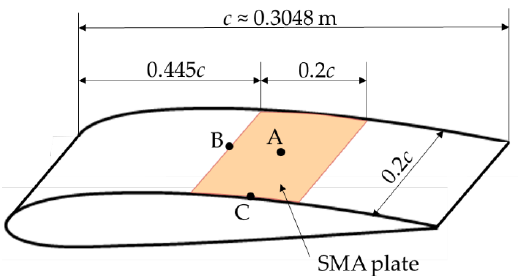
Figure 10. Conceptual sketch of a shape memory alloy (SMA) plate that is fixed on all four sides on an airfoil suction side with a chord length ( c ) of 1 ft (≈0.3048 m) based on [77]. In the initial stage the SMA plate has the shape of the original airfoil and is pre- strained, which means that the initial strains in chordwise and spanwise directions are negative. The initial temperature of the plate is −5 °C at which the SMA is fully martensitic. When the temperature is increased the SMA transforms into the austenitic phase. At the three considered points on the plate this transformation starts at about −1.8 °C and is fully completed for the point A in the middle of the plate at 6.2 °C. On the boundaries, however, a larger temperature increase is needed, since these are the areas of a high stress concen- tration. Even at the highest considered temperature of 15 °C these regions (point B and C) are not fully austenitic. However, for the formation of the bump it is sufficient that only the middle of the plate is transformed fully. Under the circumstances considered in [77], the SMA plate reaches a maximum bump height of 2.4 mm. With a given chord length of 0.3048 m this corresponds with a relative height of 0.79% chord. Nevertheless, higher bump crests can be reached within the same temperature range if the maximum transfor- mation strains are changed. For higher transformation strains a value of even 3.25 mm (1.07% chord) could be reached [77]. A similar approach is described by Zhang et al. [78] who apply an SMA plate made of NiTi with the dimensions 2 mm × 44 mm × 76.5 mm in a wind tunnel to create a bump. However, since the application described in [78] focusses on supersonic inlets and the tests are carried out at Mach 2.0 to 3.8, the aim differs somewhat from the transonic shock alleviation discussed in this review. Nevertheless, the general idea of such an SMA plate is applicable for transonic shocks as well. 2.3. Using Pressure Differences in the Shock Region The underlying idea of using perforated strips and cavities in the EUROSHOCK pro- jects [12,16], as introduced in Section 1, is based on different pressure levels which are present in the vicinity of the transonic shock. These pressure differences can lead to a re-circulation of the air flow through the cavity and perforated skin and thus affect the shock [12,16,79,80]. Moreover, these pressure differences can also be used to deform a flexible plate which is described in the following section. 2.3.1. Thin Flexible Plate Jinks et al. [81] (2015) describe a passive concept as well as an additional actuated approach. For both concepts the authors performed simulations with coupled fluid–struc- ture interaction (FSI) as well as wind tunnel measurements. Similar simulations using FSI have been performed by Gramola et al. [82,83] and Shinde et al. [84,85]. The general idea of the passive concept is based on a flexible plate on an airfoil suc- tion side that is deformed only by the depression due to the airflow aerodynamics in the transonic shock vicinity. Similar to the porosity that has been debated in Section 1, this concept applies the pressure differences in the shock regime. As depicted in Figure 11, the pressure levels in the supersonic region as well as in the direct shock vicinity are lower